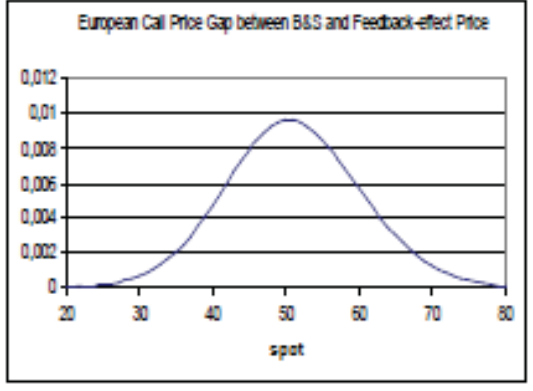
Fig. 10. European call price gap between B&S and Feedback effect price